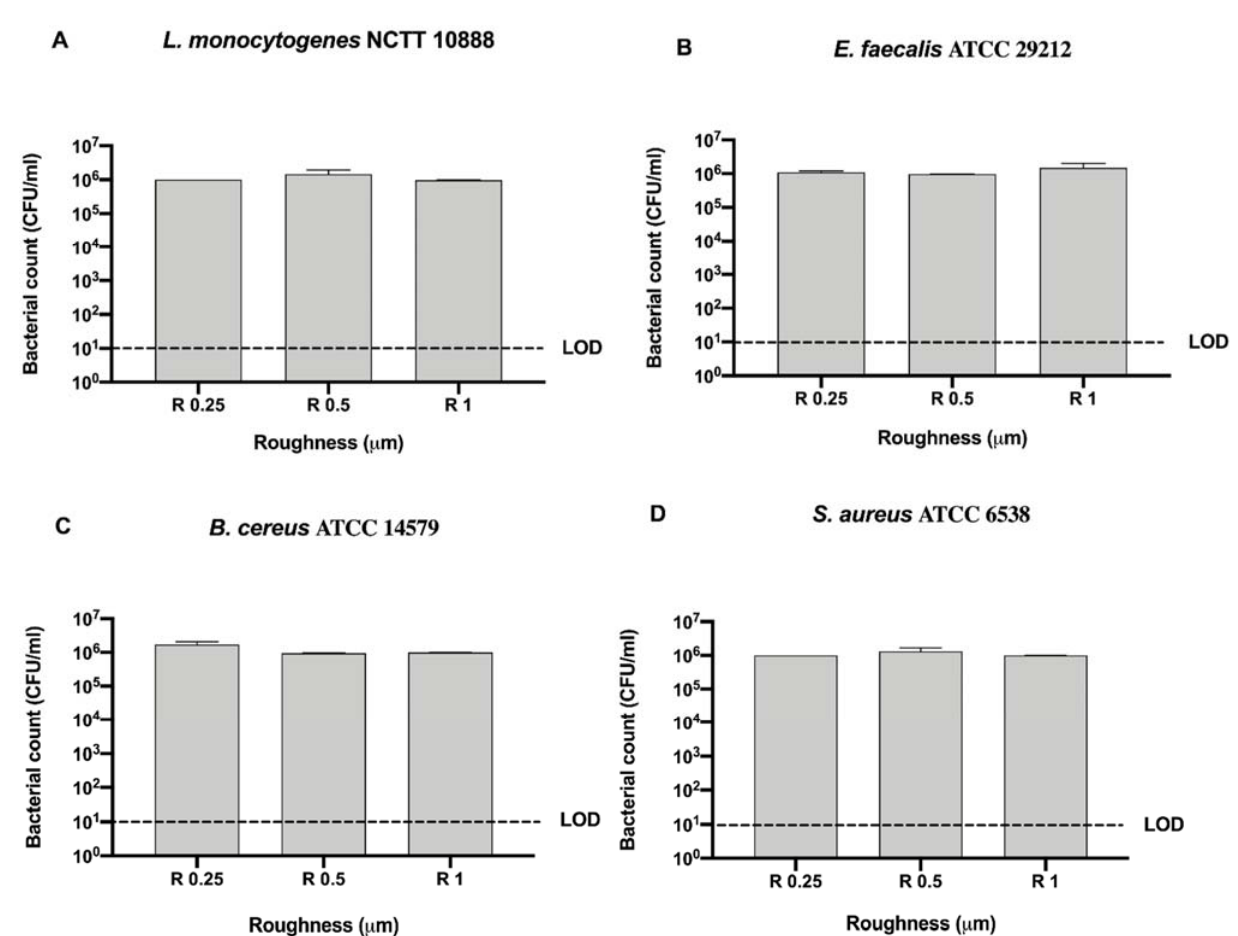
Figure 4. Graphical representation of the antibacterial activity of different AISI 316 stainless steel surface roughness against Gram-positive bacteria ( A–D ); Limit of detection (LOD) is 10 1 (10E+1).